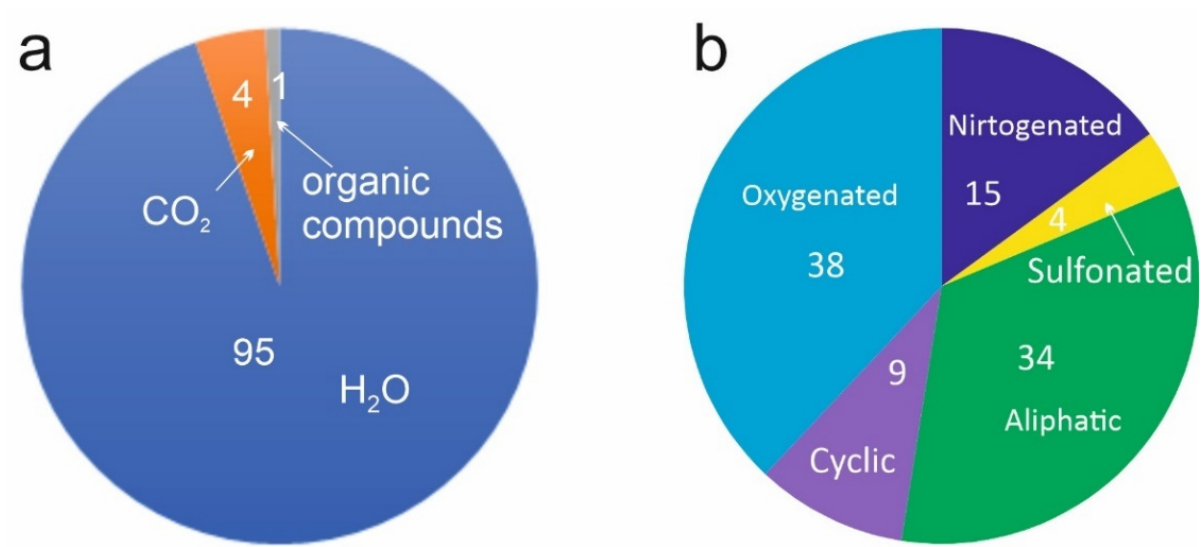
Figure 10. Composition of gas-liquid inclusions in quartz from the ore assemblage of the Rodnikovoe deposit; ( a ) gases and organic compounds (OC), relative %; ( b ) organic compounds only in relative %.